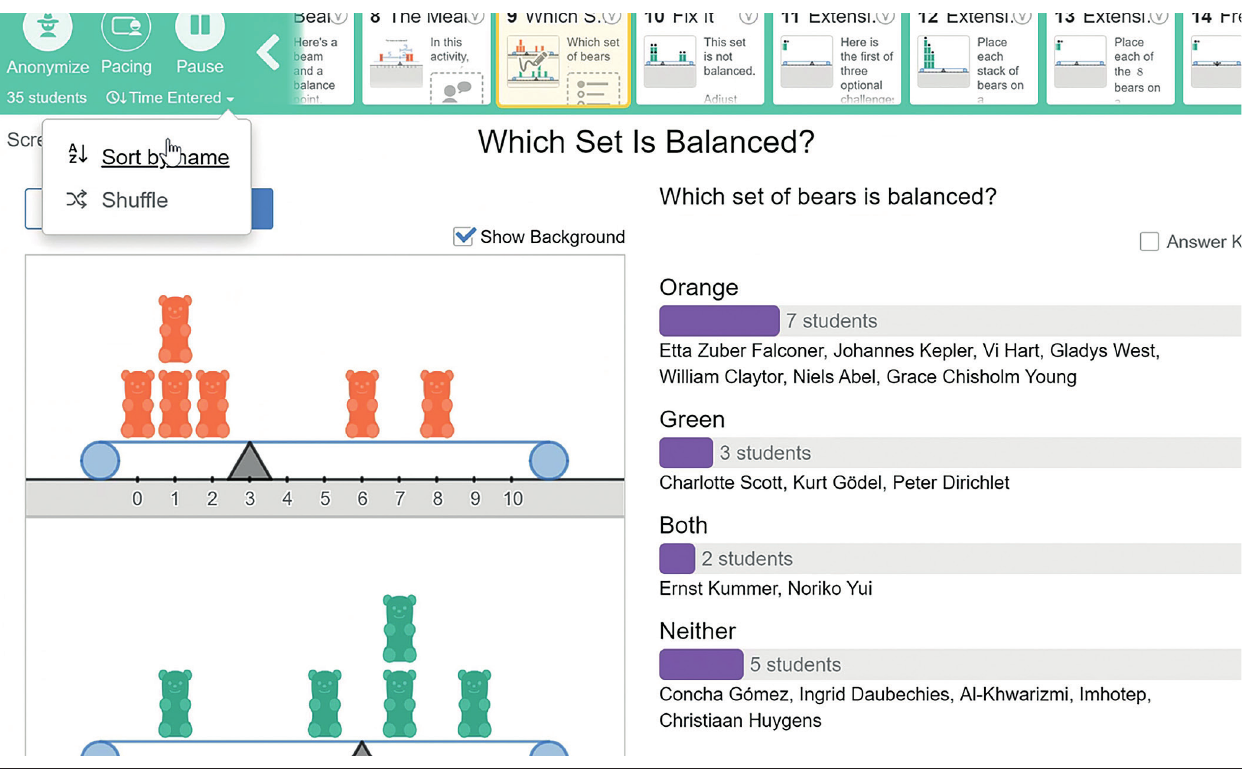
FIGURE 5: Data collected on Desmos during one of the virtual classrooms with